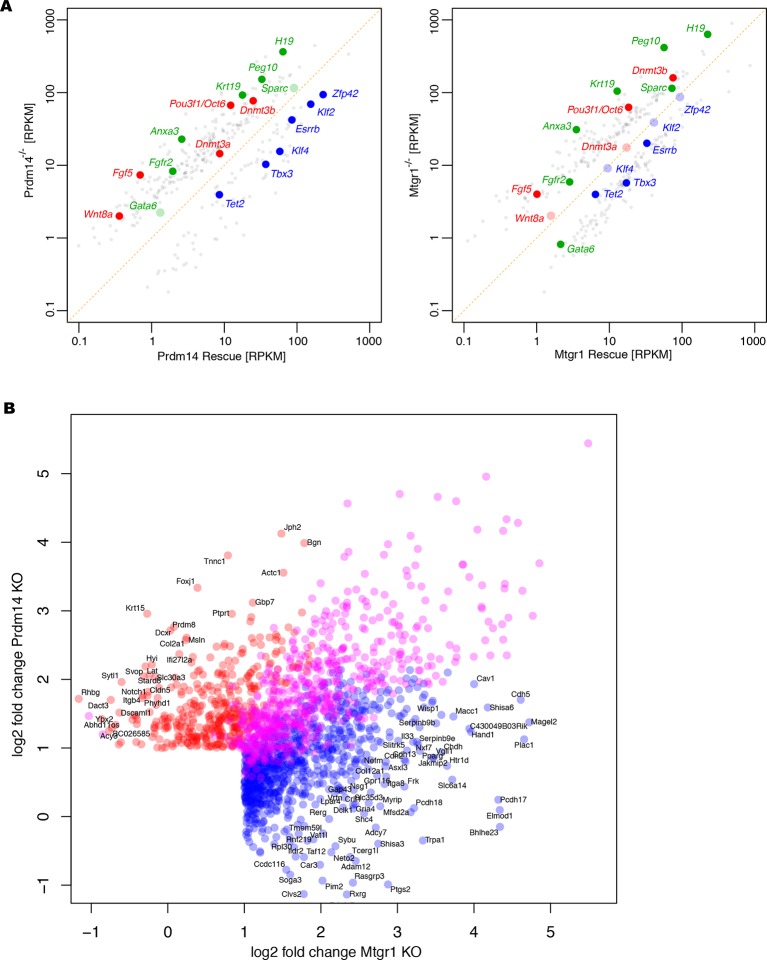
Loss of Mtgr1 results in defect in PGC-LC induction.(A) Imaging of fixed mPGC-LCs on day 6 of differentiation using bright field, DAPI (stained with Hoechst) and GFP channels. Imaging was done using z-stacks and maximum projection was taken afterwards. (B) FACS on the Stella:GFP line in ES state or PGC-LC state as indicated. Wt cells or Prdm14-null, Mtgr1-null or respective rescue lines were used. DAPI, 4',6-diamidino-2-phenylindole; GFP, green fluorescent protein; FACS, fluorescence-activated cell sorting; mPGC-LCs, mouse primordial germ cell-like cells; wt, wild type; Mtgr1, myeloid translocation gene related 1.